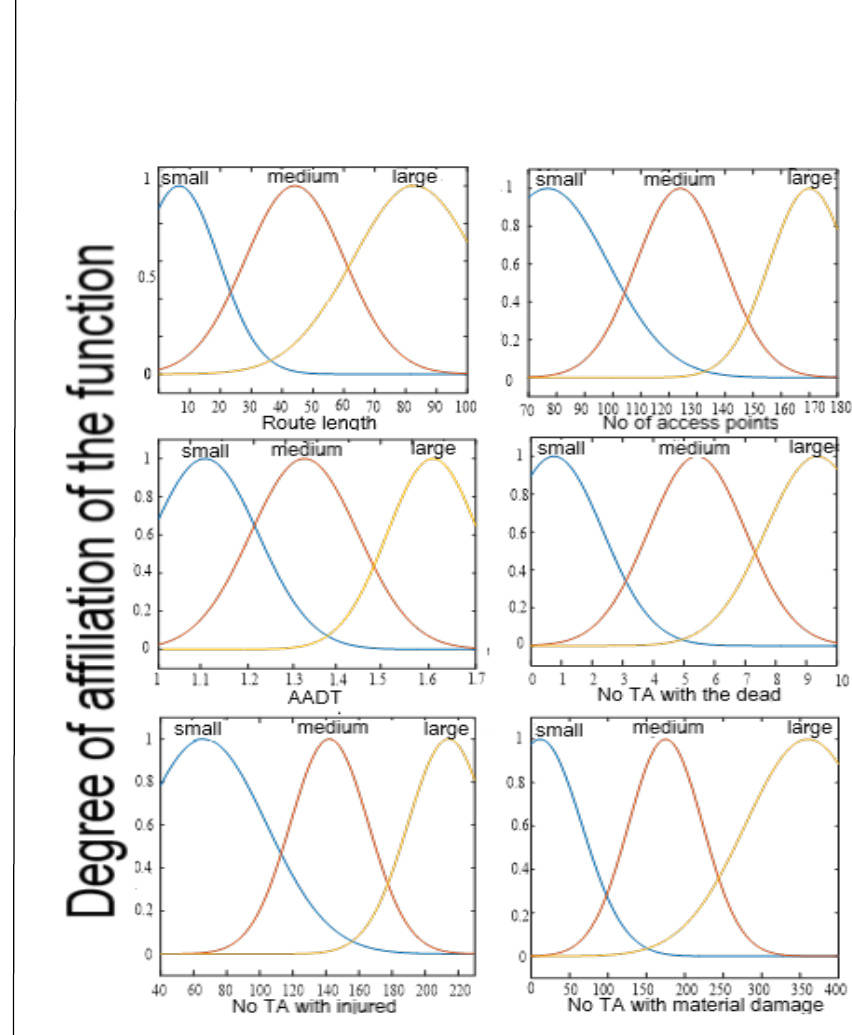
Figure 2 – Function of belonging of linguistic variables: Length of the route, Number of access points, AADT, Number of TA with fatalities, Number of TA with the injured and Number of TA with material